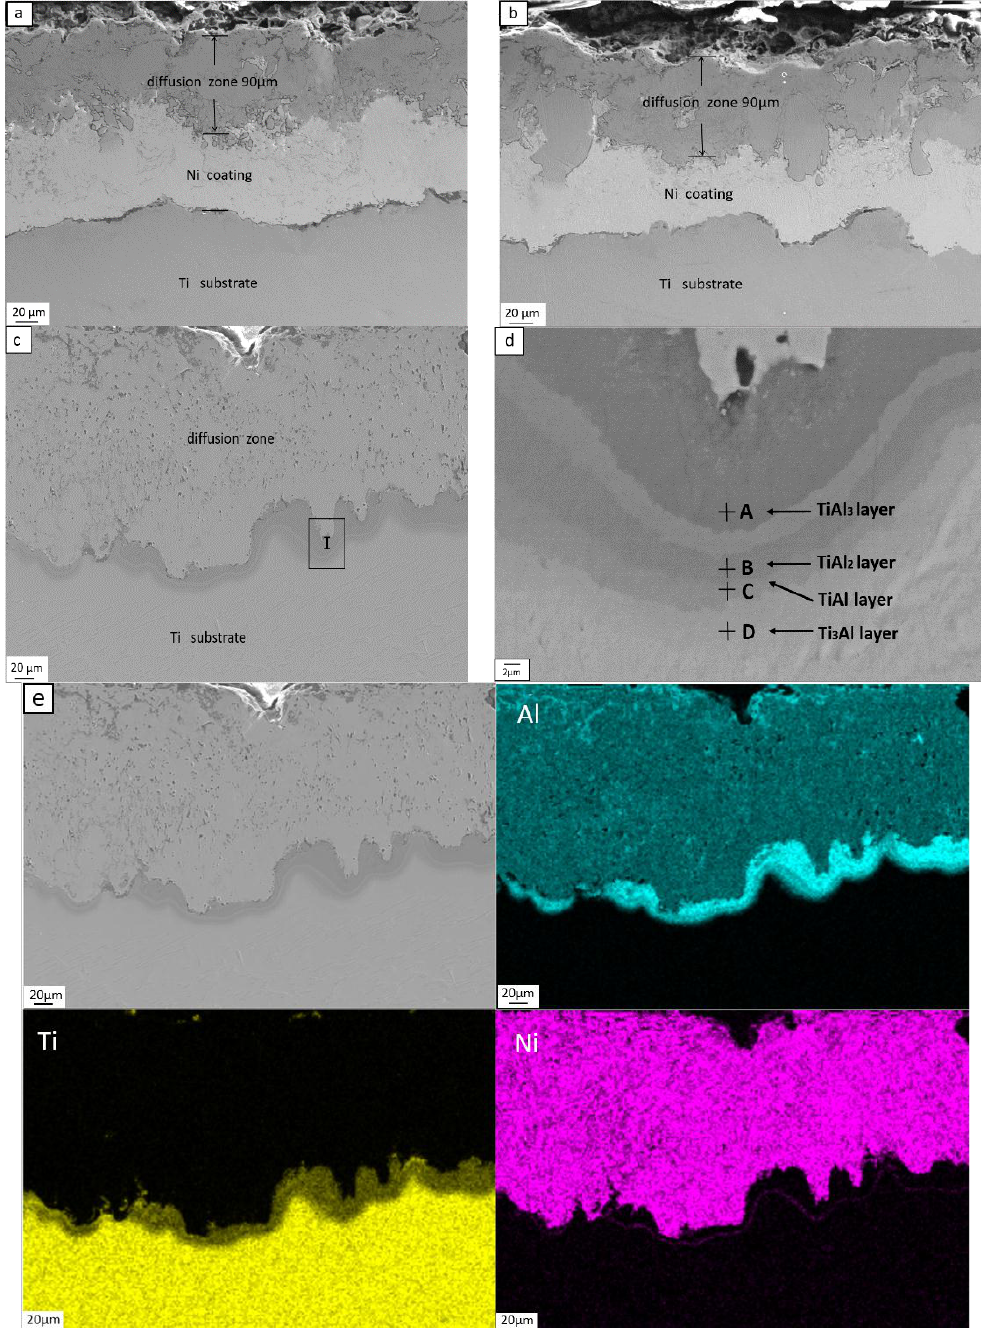
Figure 7. ( a ) Cross-sectional SEM image of Al/Ni coating (Al coating 50 μm thick) after testing for 5 h at 1173 K; ( b ) cross-sectional SEM image of Al/Ni coating (Al coating 50 μm thick) after testing for 10 h at 1173 K; ( c ) cross-sectional SEM image of Al/Ni (Al coating 150 μm thick) coating after testing for 10 h at 1173 K; ( d ) expanded view of region I in ( c ); ( e ) distributions of elemental Al, Ti, and Ni in ( c ).